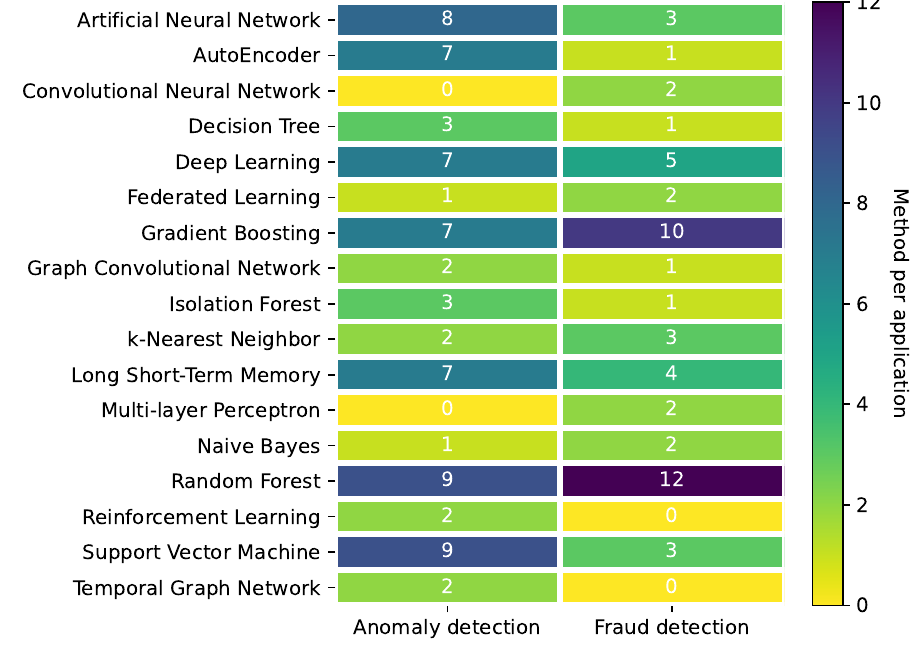
Figure 3. Heatmap of the most used methods per